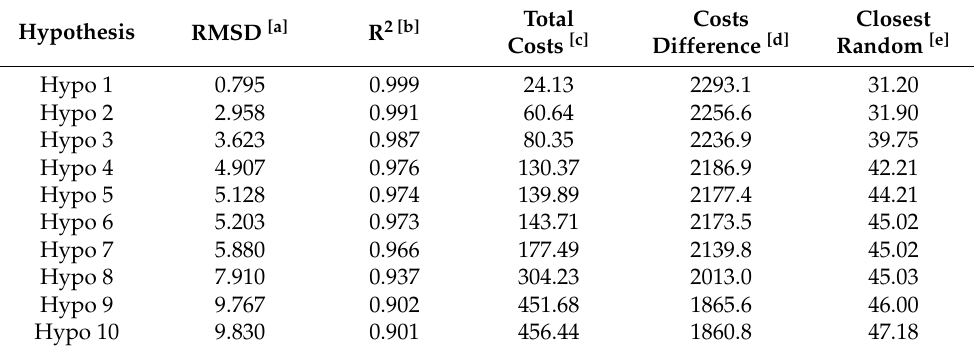
Table 4. Output parameters of 10 generated PH4 pharmacophoric hypotheses for FP3 inhibitors after Cat-Scramble validation procedure (49 scrambled runs for each hypothesis at the selected level of confidence of 98%).